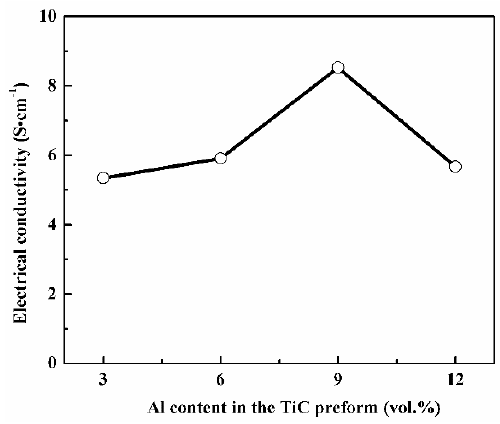
Figure 7. Electrical conductivity as a function of Al content in TiC preform.